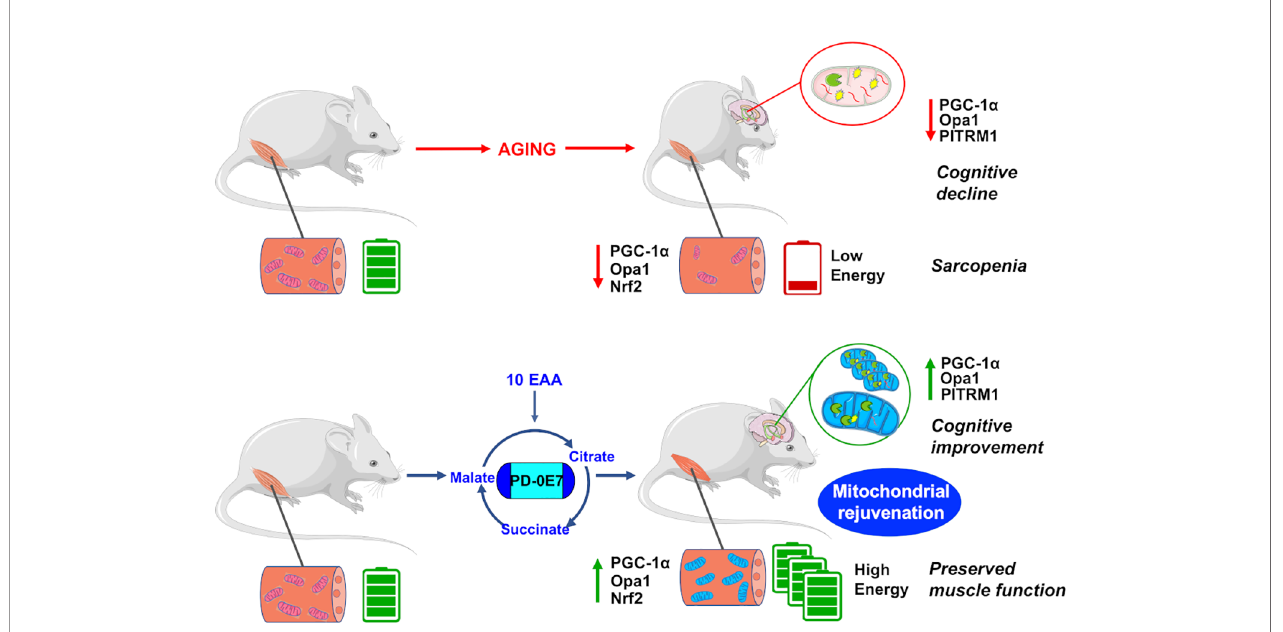
FIGURE 7 | Reduced mitochondrial quality control impairs bioenergetic activity in the skeletal muscles and hippocampus, leading to motor and cognitive dysfunctions in aged mice. Dietary supplementation with the metabolic modulator PD-0E7 preserves mitochondrial ef fi ciency and reverses mice functional